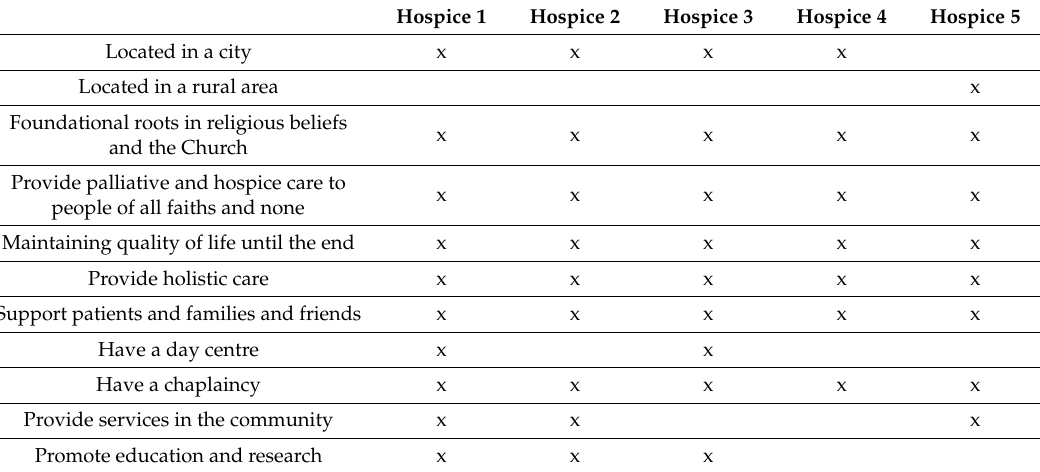
Table 1. Hospice organization characteristics.